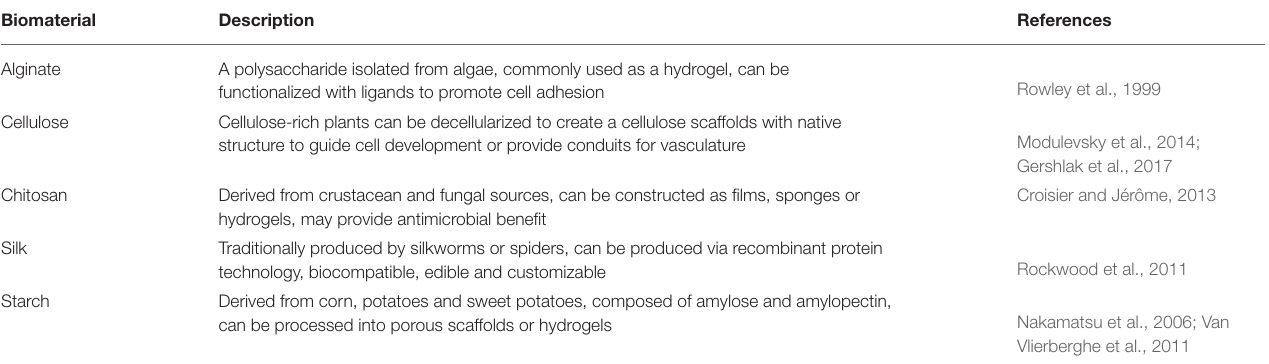
TABLE 4 | Biomaterials potentially suitable for cellular agriculture scaffold applications.